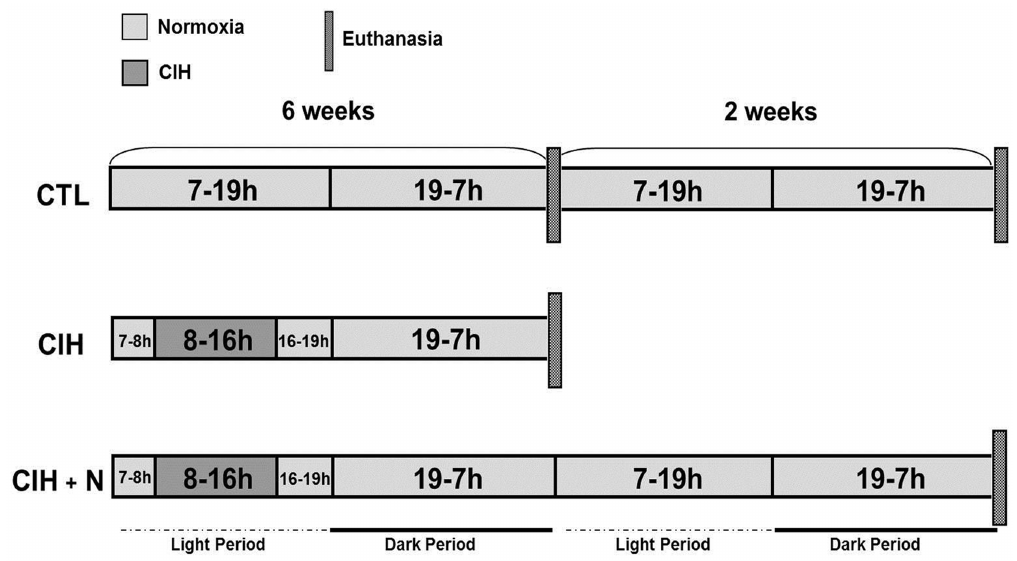
Figure 1. Experimental protocol. Experimental timeline for each group: CTL (control group, n=8); CIH (animals subjected to 8-hours/day of chronic intermittent hypoxia for six weeks, n=8); CIH + N (animals subjected to 8-hours/day of chronic intermittent hypoxia for six weeks followed by a two-week recovery period, n=8).